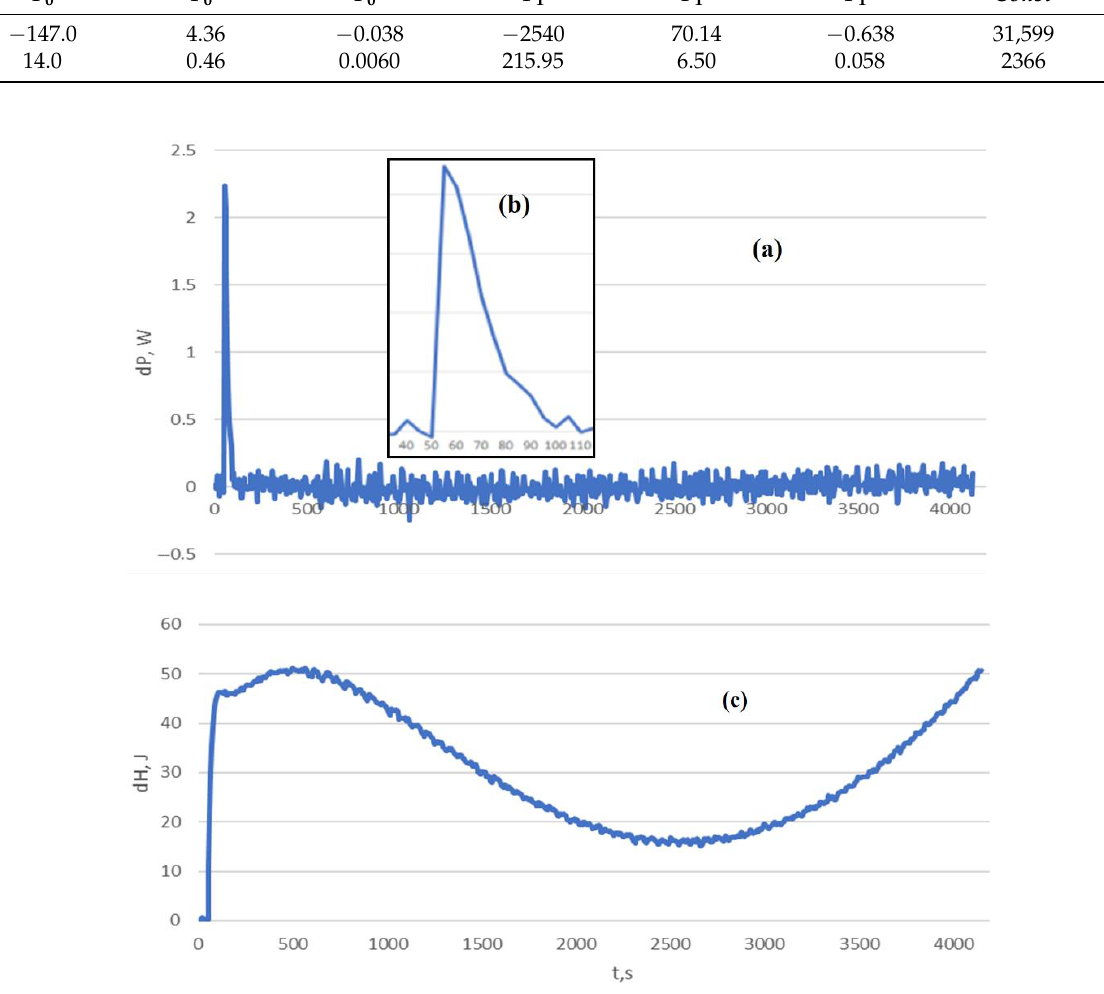
Figure 8. Residual enthalpy for T 0 Equation in (15) with coefficients from Table 4. Table 4. The coefficients for Equation (15). a 01